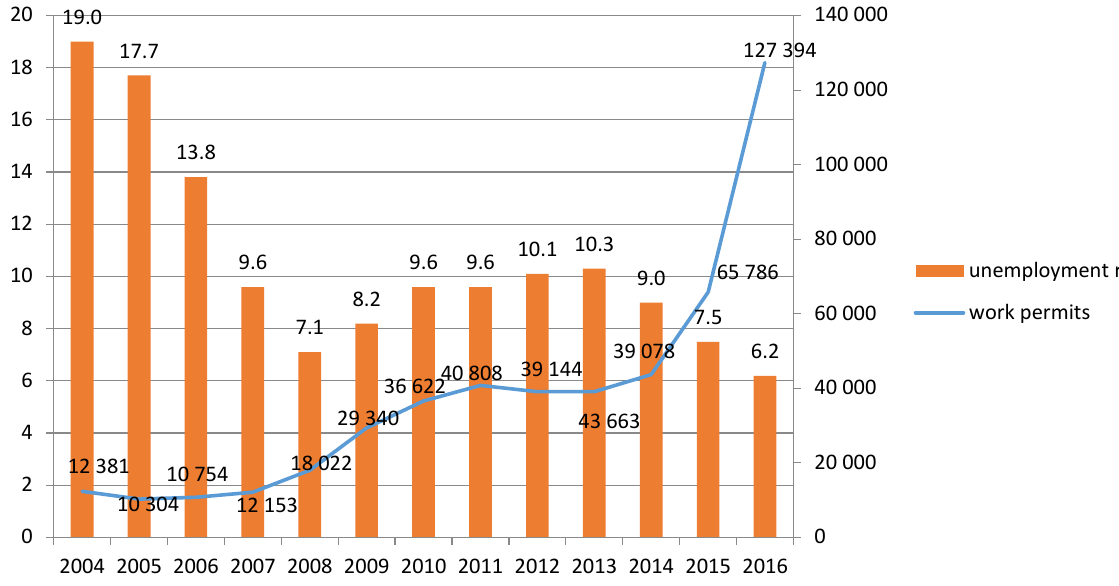
Source: CSO (2017a) and Ministry of Family, Labour and Social Policy (2018b). Figure 2. Declarations submitted (right axis) and unemployment rate (left axis) in Poland, 2007–2016